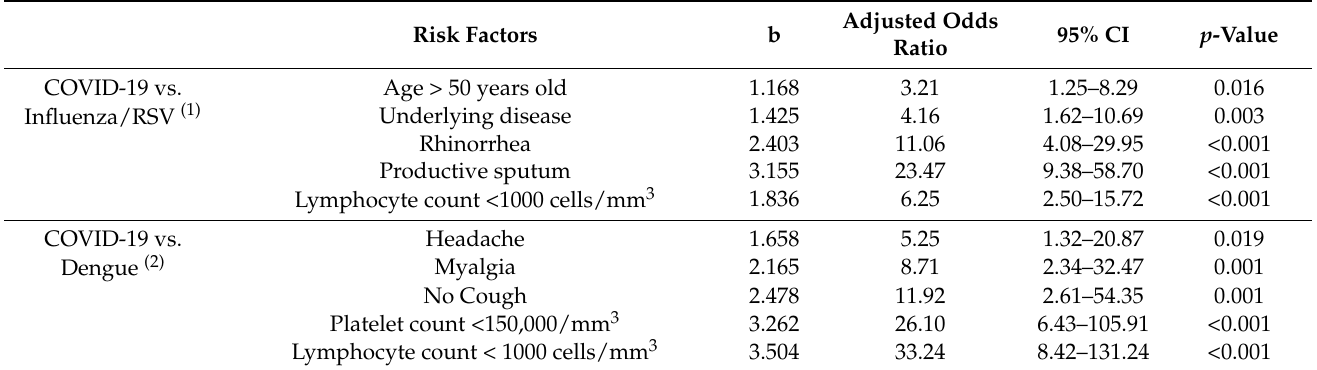
Table 5. Multiple binary logistic regression analysis of factors differentiating between COVID-19 and influenza/RSV or dengue.